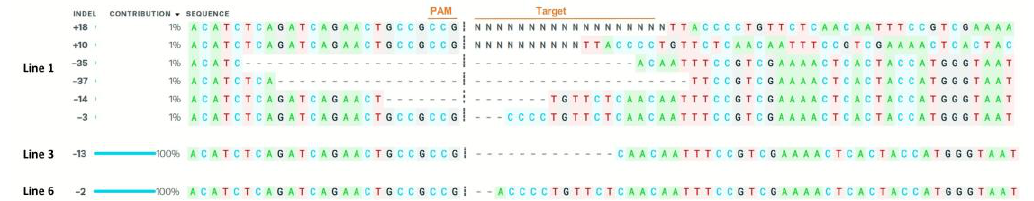
Figure 3. Analysis of CRISPR/Cas9-induced knock-out lines using ICE CRISPR Analysis Tool. Deletions are indicated by a dotted line. The PAM site is shown in red.